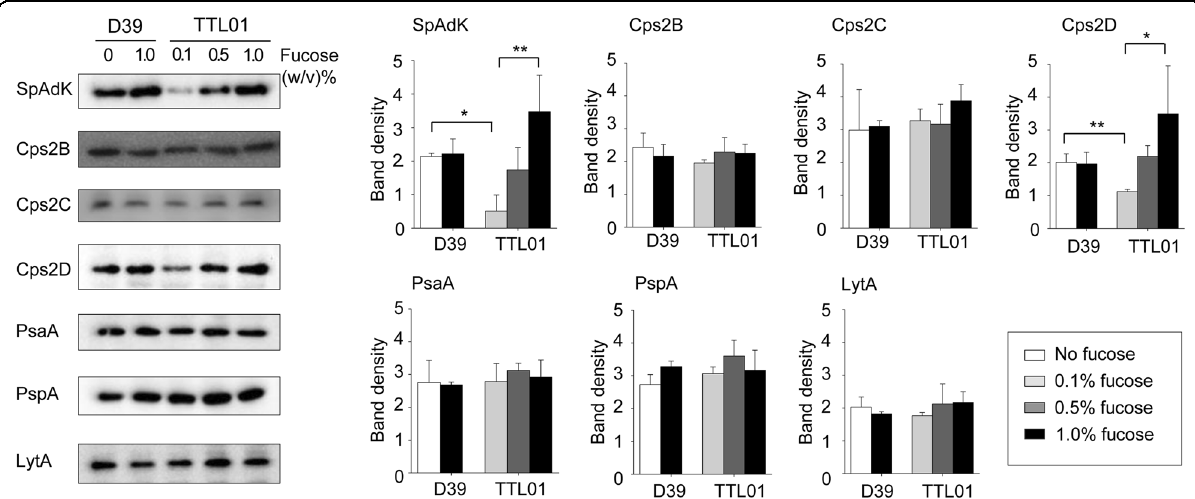
Fig. 2 SpAdK increases Cps2D but not Cps2B/C levels. S. pneumoniae lysates were collected and subjected to western blotting with appropriate antibodies. The experiments were repeated independently three times. ImageJ software was used for densitometry analysis and to determine